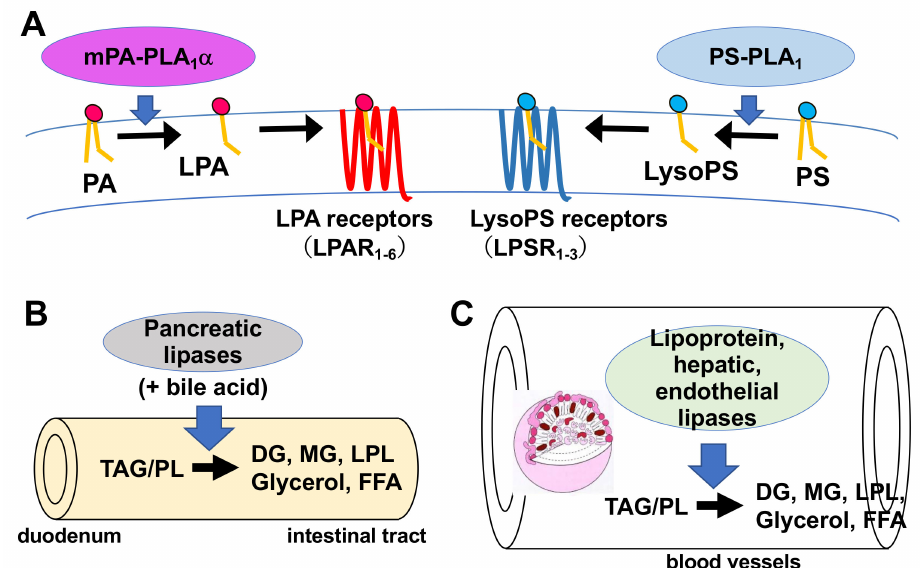
Figure 3. Physiological roles of extracellular PLA 1 s. ( A ) PS-PLA 1 and mPA-PLA 1 α serve as